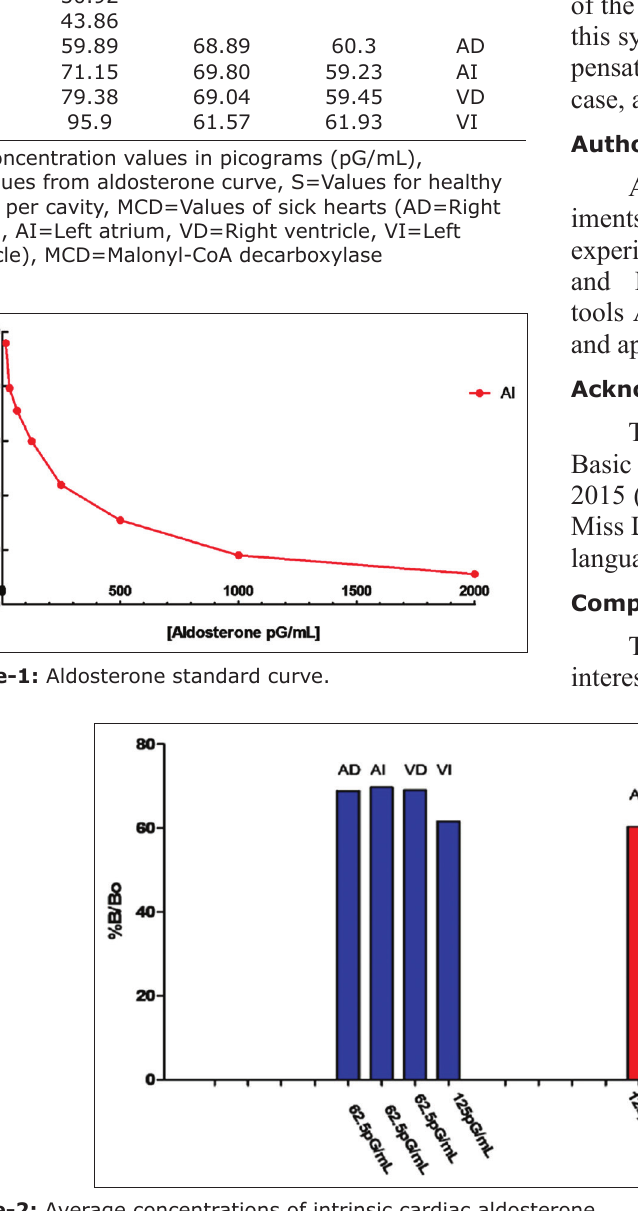
Figure‑2: Average concentrations of intrinsic cardiac